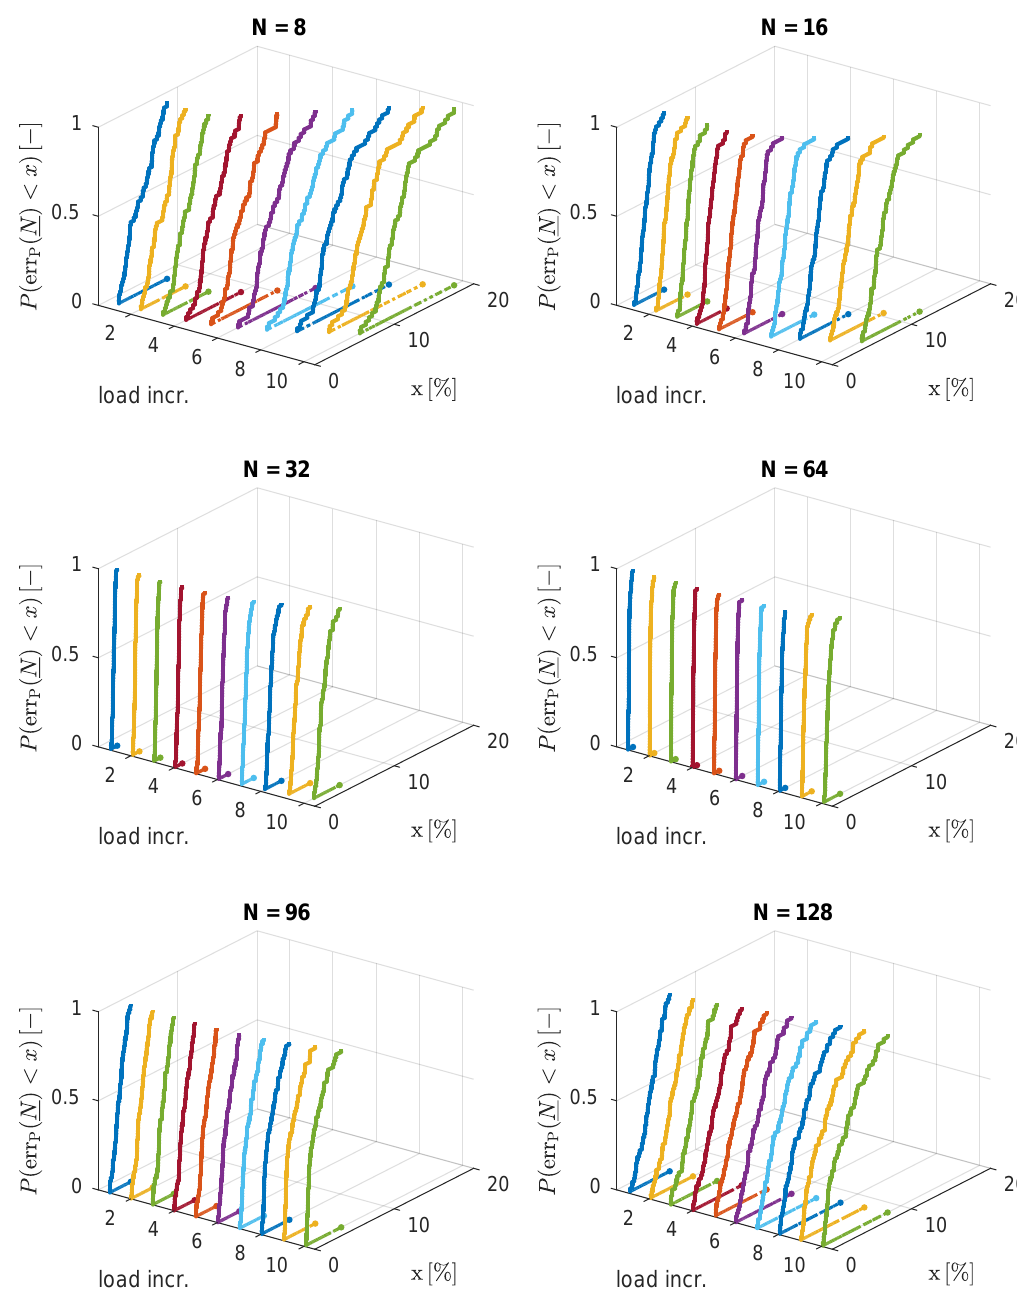
Figure 7. Cumulative stress error distribution per direction for the RB of the fibrous microstructure under validation boundary